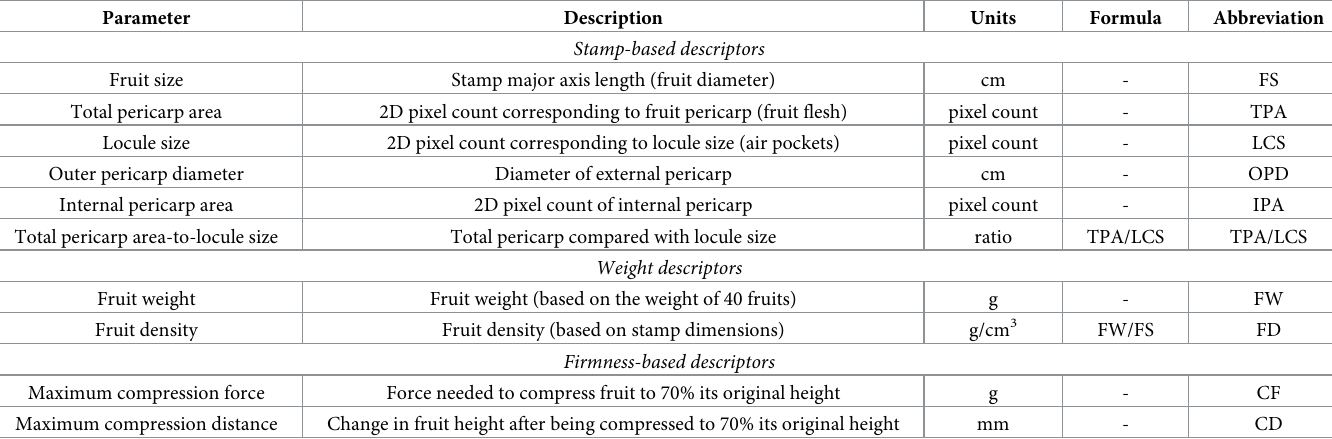
Table 1. Properties of cranberry fruit measured in this